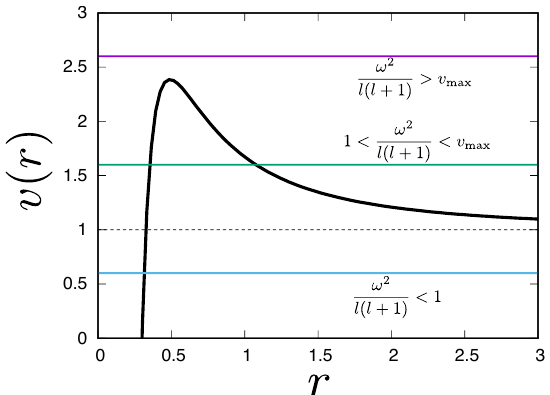
Figure 18 . Effective potential for Maxwell perturbation equations for r h = 0 . 3